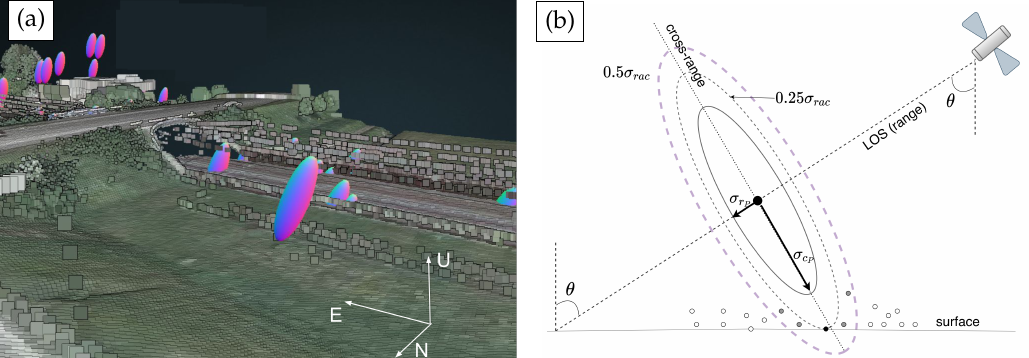
( a ) Example of error ellipsoid from Potree viewer (center latitude and longitude is 51.840 ◦ N, 5.030 ◦ E). The ratio (azimuth: range: cross-range = 1:1.5:6) of semi-axis length is taken for visualization purposes. ( b ) A cross-section of error ellipsoid in range and cross-range dimensions. The error ellipsoid is centered at PS ( r P , c P ) in range and cross-range plane, with the semi-major and minor length σ c and σ r . The associated real object on surface for this PS is denoted as the black solid circle given P P 25% significance level, when having the 3 × 3 error matrix σ rac = diag ( σ r , σ a , σ c ) . Adapted from